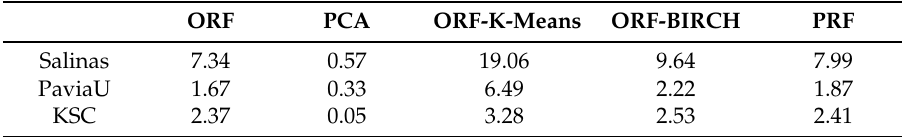
Table 8. Runtimes of various methods